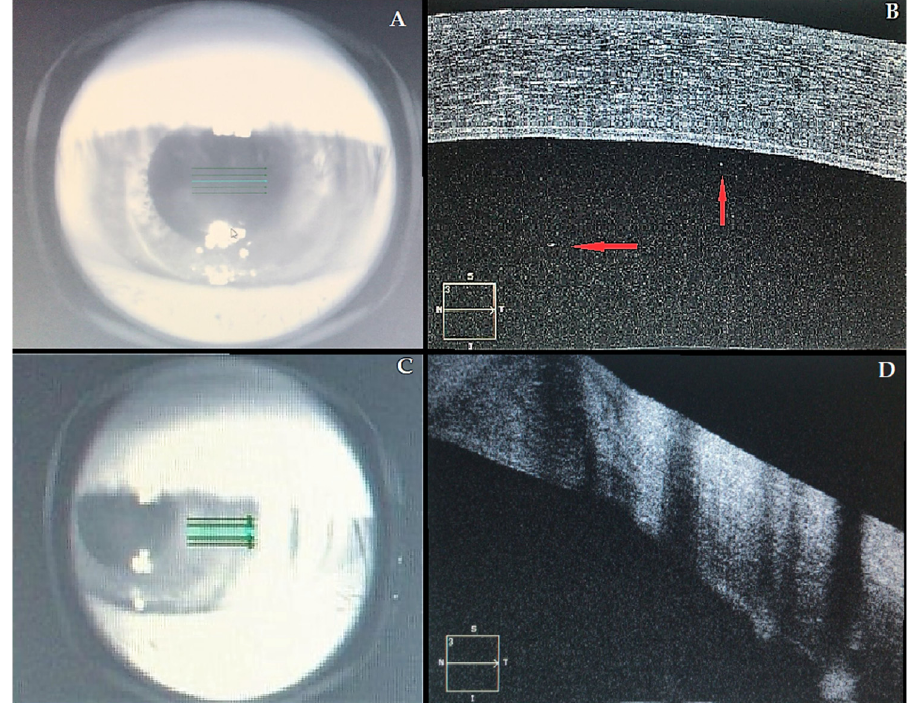
Figure 1. acute corneal graft. ( A – C ) Infrared images of the left eye; ( B – D ) correspondent OCT images. Central cornea ( A , B ): in Figure 1B, it is possible to observe a marked corneal edema and a series of morphological changes (see text). Red arrows indicate a number of inflammatory floaters in the anterior chambre. Transition area ( C , D ) between the recipient’s cornea (normal thickness) and the graft (thickened by edema). Table 2. Blood exams of the patient. Abnormal data are indicated in bold.